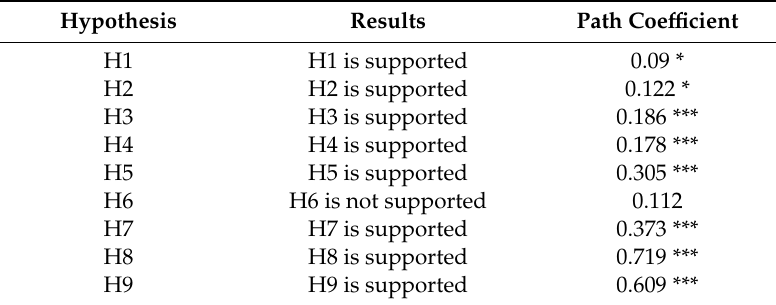
Figure 2. The result of the full model. Note: * p < 0.05, ** p < 0.01, *** p < 0.001. Table 4. Path coefficient analysis.